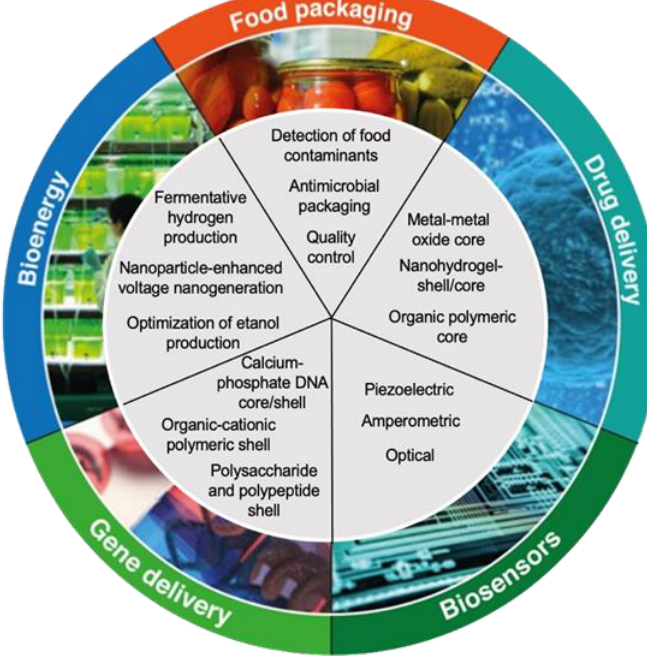
Figure 2. Bionanocomposites: Versatility and their applications in different industries.